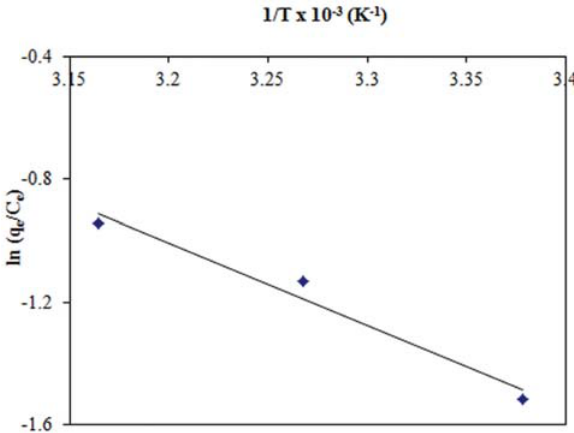
Figure 5. ln(q /C ) versus 1/T plot for the estimation of thermody- e e namic parameters for MG adsorption onto untreated